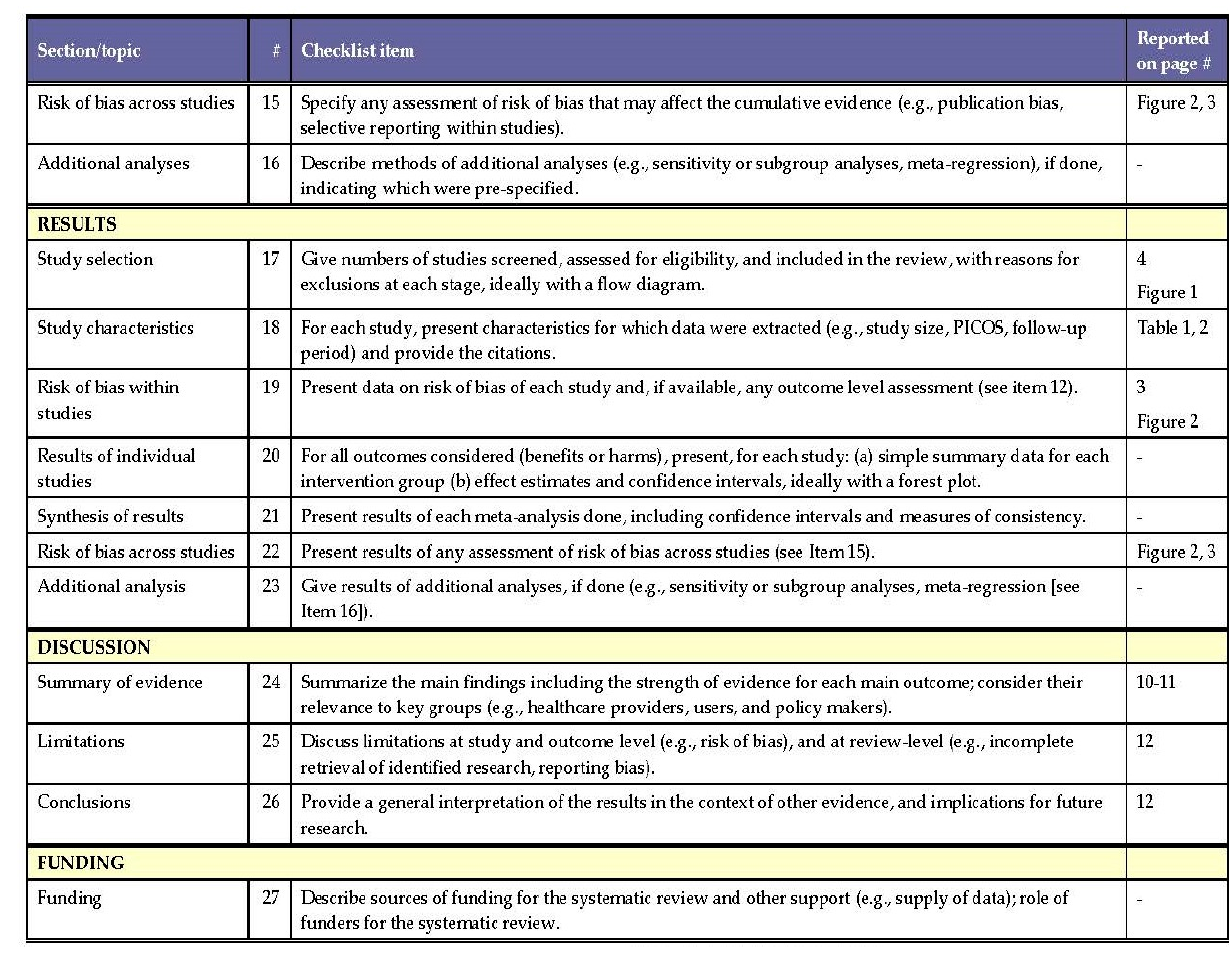
Figure A2. PRISMA Checklist [35].